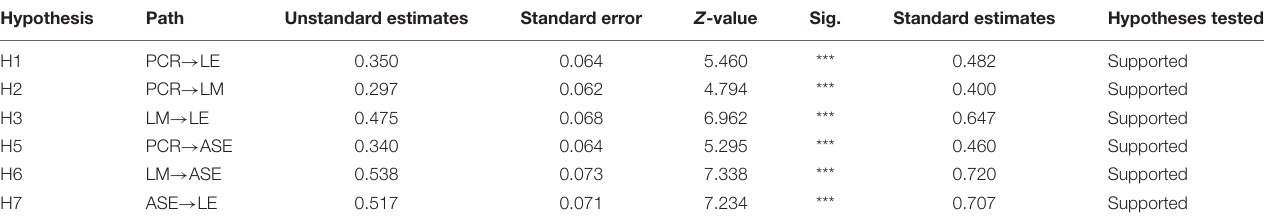
TABLE 5 | The test results of path relationship.